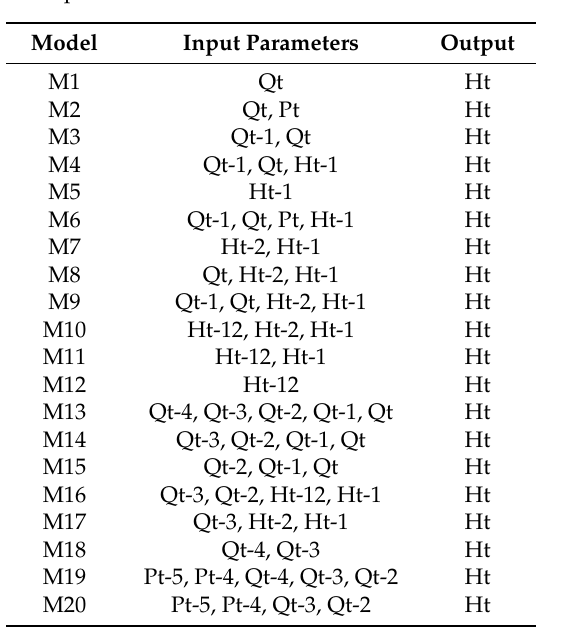
Table 2. Different input combination used for ANFIS and GWO-ANFIS